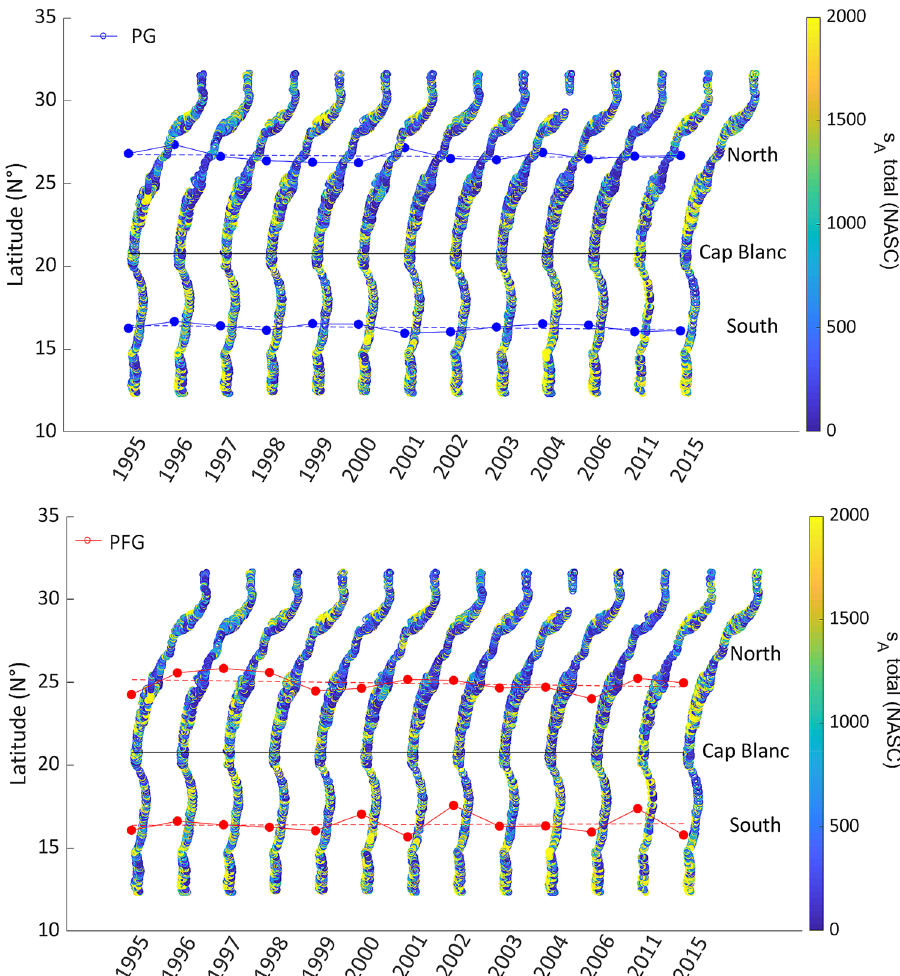
Figure 4. Differences in the two dimensional horizontal barycenter of the two trophic levels studied: (top) zooplankton, micronekton, and ichthyoplankton (named plankton group (PG), blue dots), and (down) pelagic fish and other higher pelagic trophic levels (named pelagic fish group (PFG), red dots). Dashed lines represent the linear trends for each